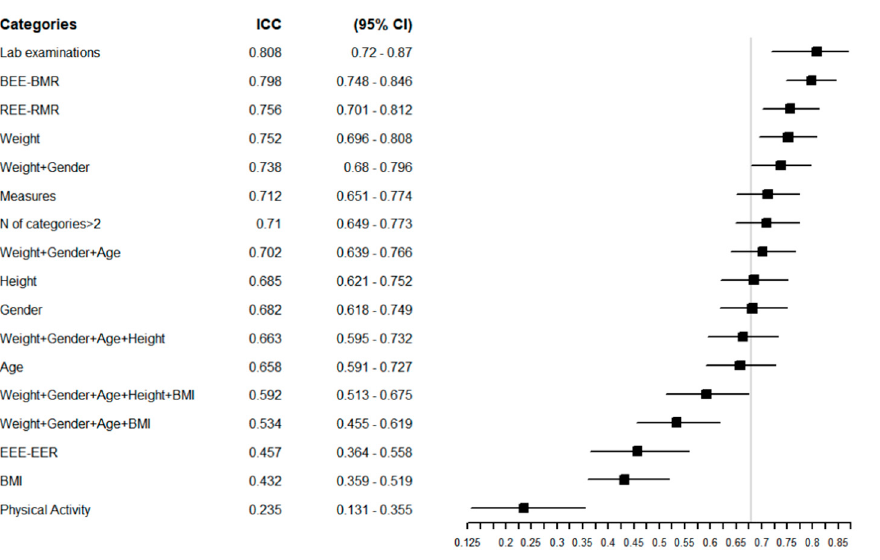
Figure 2. Forest plot reporting the Intraclass Correlation Coefficient (ICC) with 95% CI of estimated REE in the overall population for each specific group of predictive equations. The vertical grey line represents the ICC in the whole category without any grouping: ICC = 0.68 [0.62–0.75] 95% CI. Additionally, in males, equations that included laboratory examinations showed a good agreement level (0.94 [(95% CI = 0.87–0.97)]. In examinations of agreement according to gender, females had a higher overall agreement level of 0.67 (95% CI = 0.59–0.75), with